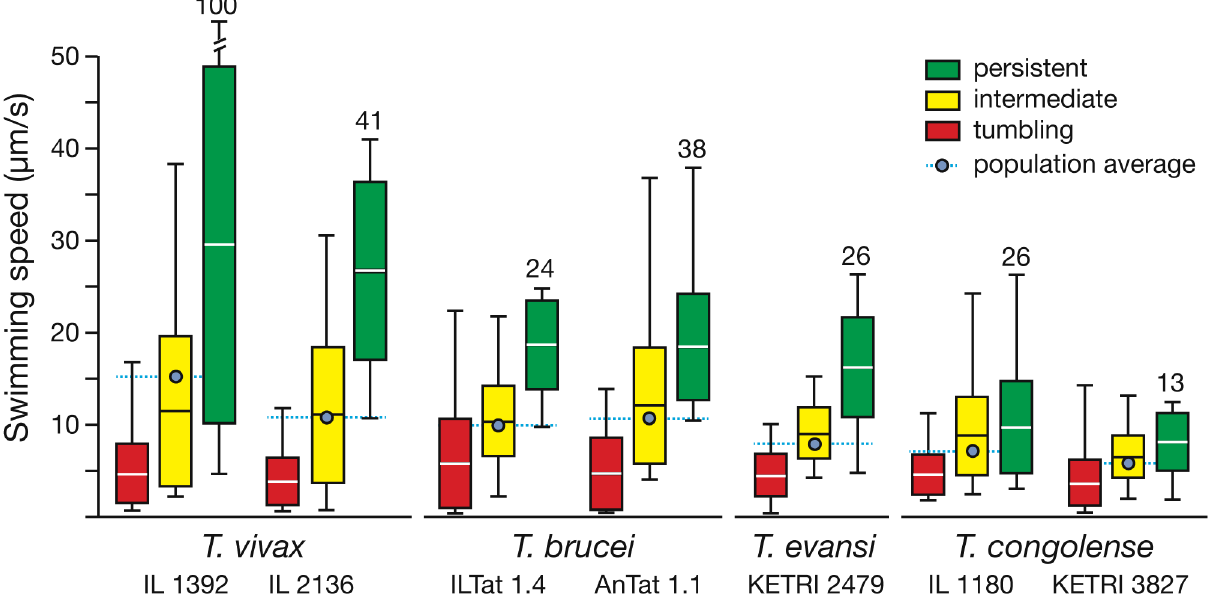
Fig 2. Trypanosome velocities in mouse blood. Each bar represents the analysis of 100 high-speed videos (500 fps, 16 s recording time). The bars present the mean swimming speed +/- SD. Black lines depict the individual maximum and minimum speeds recorded. The maximum speeds for persistent swimmers are annotated. The average population swimming speed of a species was calculated from all 300 trajectories and is marked by the blue dot.